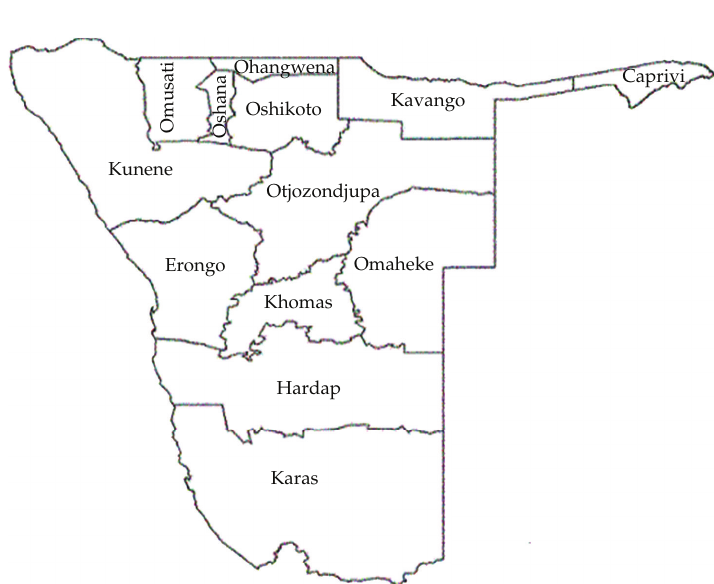
Figure 1: Regional boundary map of